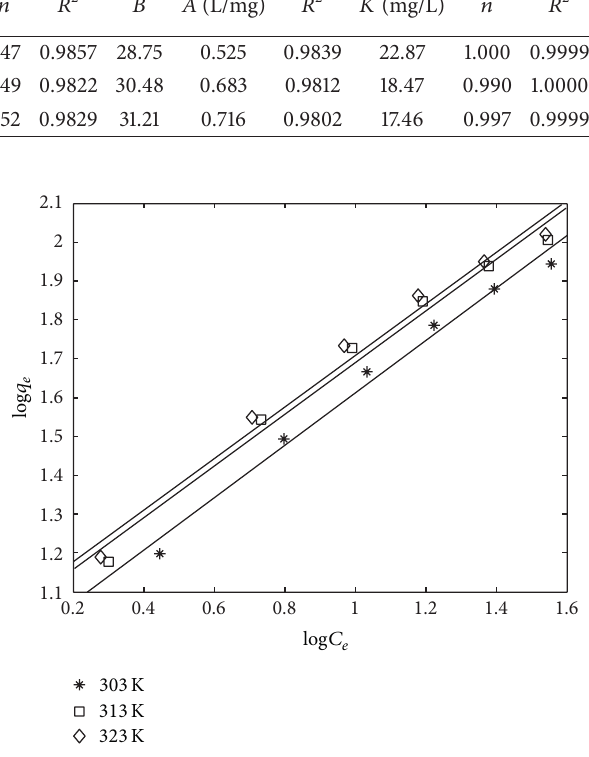
Table 3: Langmuir, Fruendlich, Tempkin, and generalized isotherm constants for MB onto PTMF at different temperatures. 𝑇, K Langmuir isotherm Fruendlich isotherm Tempkin isotherm Generalized isotherm